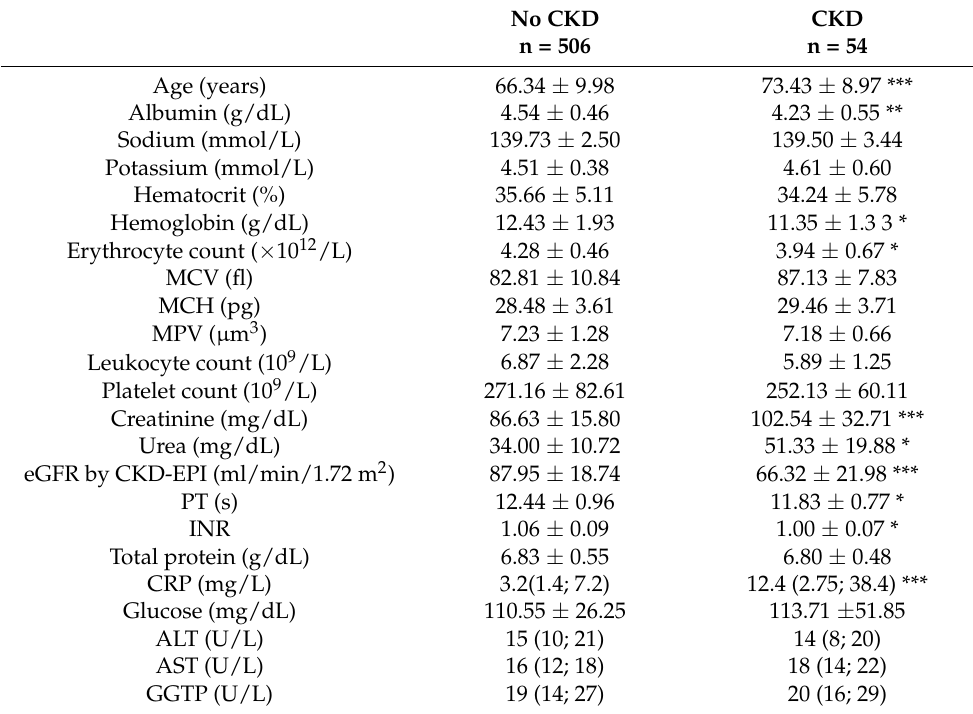
Table 2. Clinical and biochemical data of colorectal cancer patients with and without chronic kidney disease CKD.